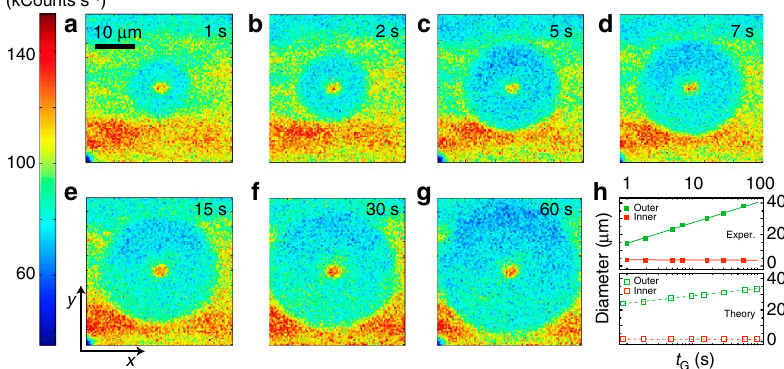
Figure 5 | Time evolution of the photo-induced NV (cid:2) pattern. Following a green scan (reset), we use a weak red beam to image the pattern resulting from green, fixed-point illumination of variable duration t G . Unlike the protocol in Fig. 3, no prior bleaching is carried out. The green, fixed-point illumination times are ( a ) 1s, ( b ) 2s, ( c ) 5s, ( d ) 7s, ( e ) 10s, ( f ) 15s, ( g ) 30s and ( h ) 60s. The green and red laser powers are 1.8mW and 100 m W, respectively. All images are recorded by scanning the red laser beam one time. All other conditions as in Fig. 4. ( h ) Observed (upper graph) and calculated (lower graph) dependence of the inner and outer diameters of the NV (cid:2) pattern as a function of t G . Filled (empty) squares are experimental (calculated) data points; solid and dashed lines serve as a guide to the eye. The scale bar in a and axes labels in e apply to all scanned images. All parameters as listed in Supplementary Table